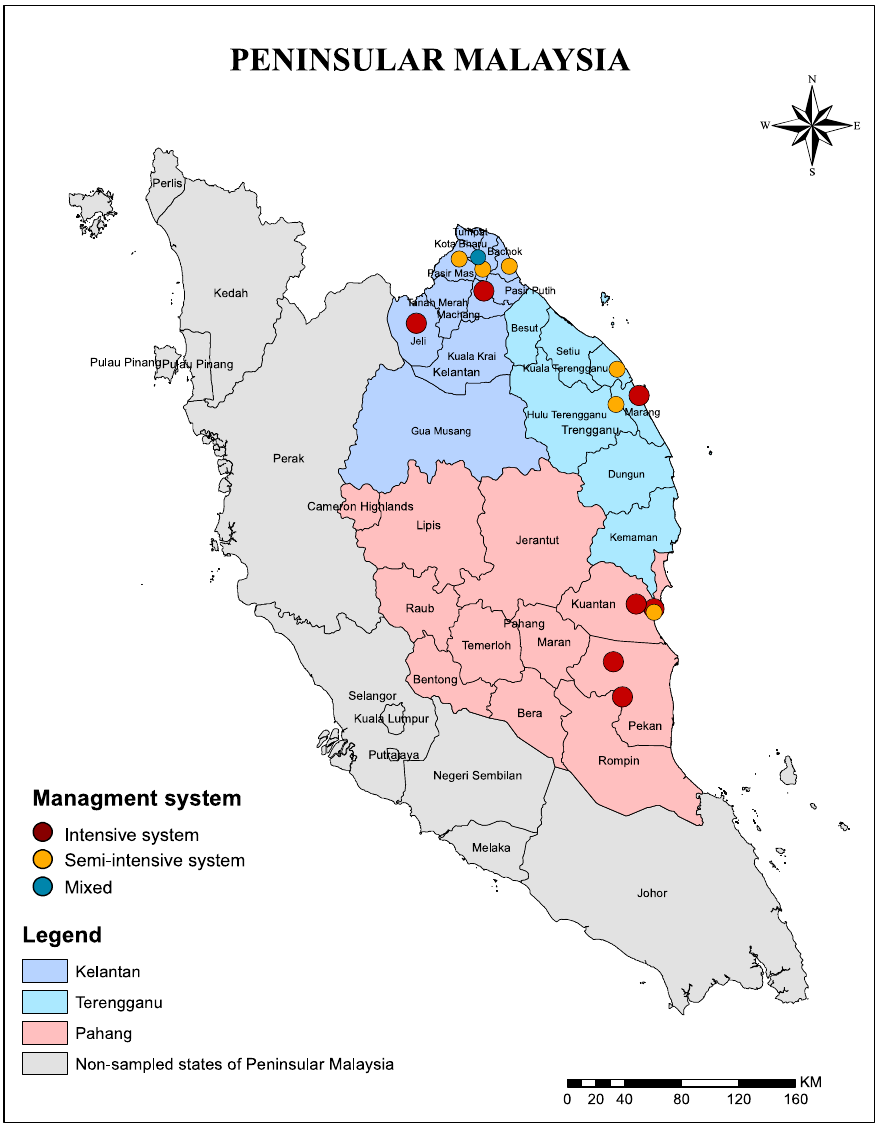
Figure 4. A map showing location of the sampled states and exact location 14 poultry farms sampled and their management systems in Kelantan, Terengganu, and Pahang of east cast peninsular Malaysia. The map was created using ArcGIS v. 10 (esri Inc., Redlands, CA, USA).